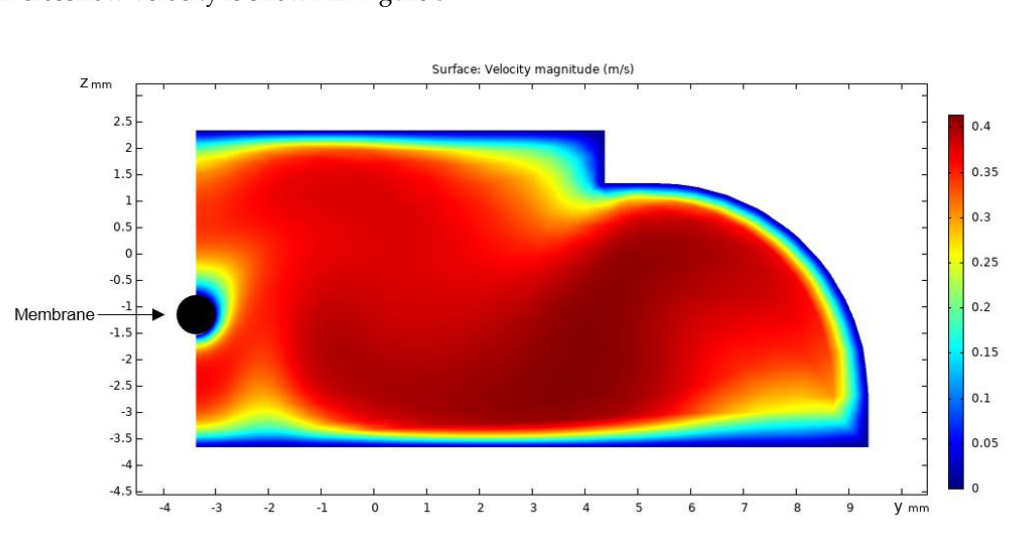
Figure 3. Surface velocities in the right half cross sectional plane of the filtration cell calculated by CFD modelling using a crossflow of 160 kg/h and 2 bar TMP.